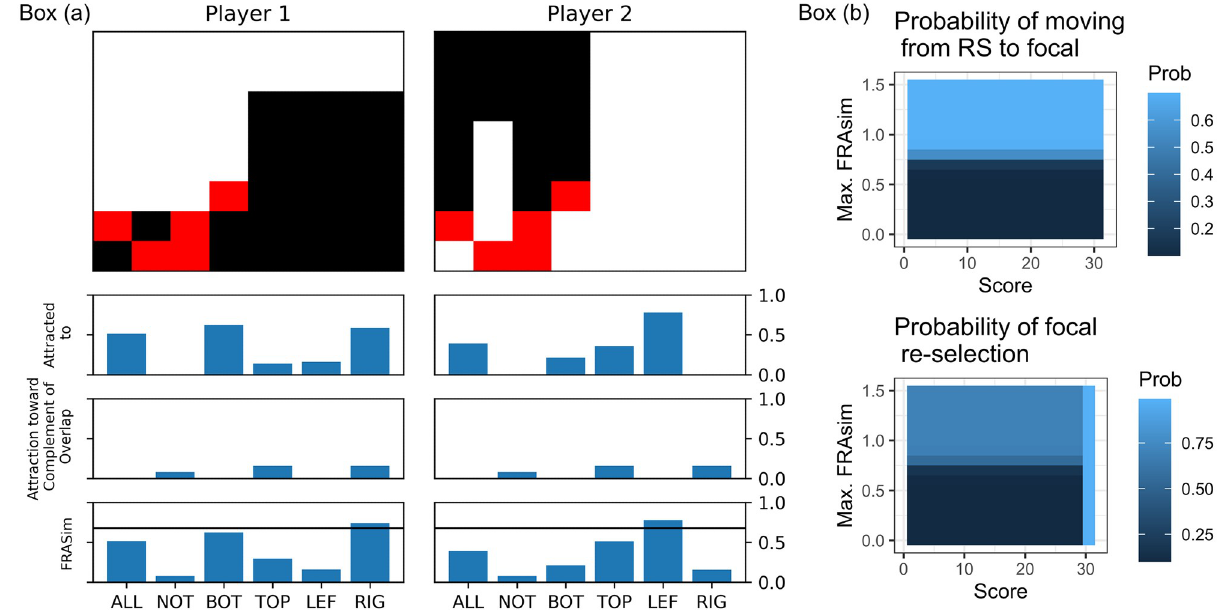
Fig 6. The mechanisms of FRA in action. Box (a) top panels: Regions explored by each of the two players with overlapping tiles in red, drawn over an actual gameplay. Box (a) second from top panels: Attraction exerted by focal regions in terms of their similarity to the explored region. Box (a) third from top panels: Attraction towards a focal region in terms of the similarity between the complement of the overlapping region and the focal region. Box (a) bottom panels: FRASim of each focal region, which adds up the two previous similarities. These panels also display a threshold line which, when a region surpasses it, triggers considerable attraction towards this region (focal regions IN and OUT are not shown for ease of presentation). Box (b) top panel: Heatmap of the probability surface representing the probability that a player who has selected a random region on the previous round chooses a focal region, as a function of score and FRAsim levels. In this case, FRA predicts that the score level does not influence this movement, which can be reflected by the uniform surface along the score-axis. Box (b) bottom panel: the surface corresponding to the probability of focal re-selection depending on the previous score and the maximum FRAsim obtained on the previous round. Observe that, in this case, high score levels predict high probability of re-selection.